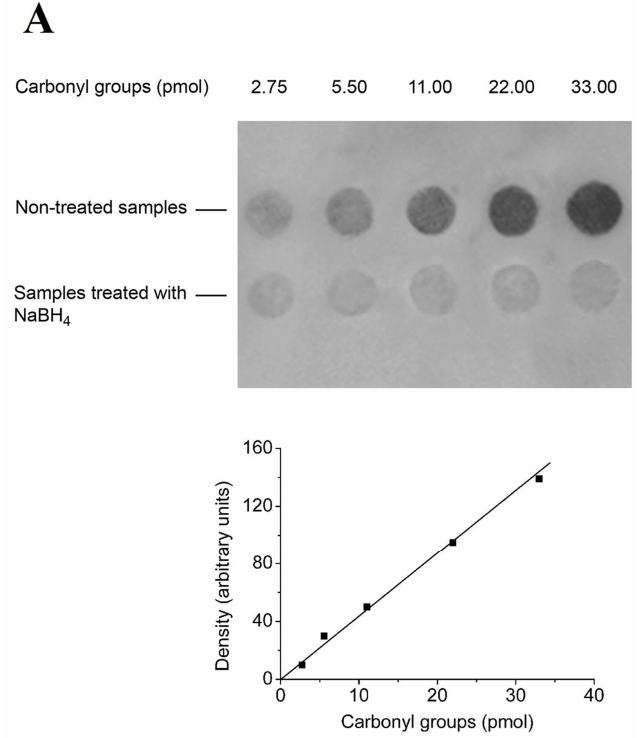
Fig.2.jpg (JPEG Image, 7972 × 14222 pixels) - Scaled